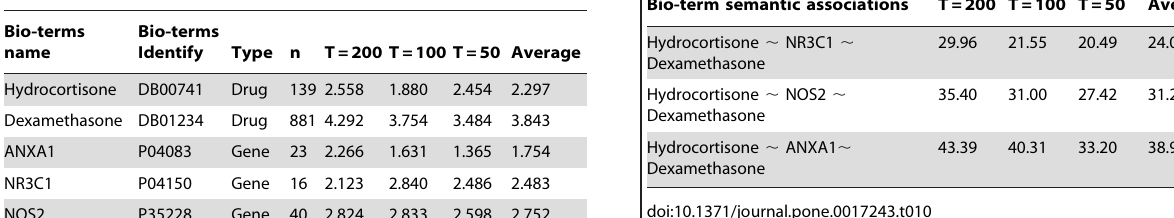
Table 10. Symmetric KL divergence for the top 3 paths.